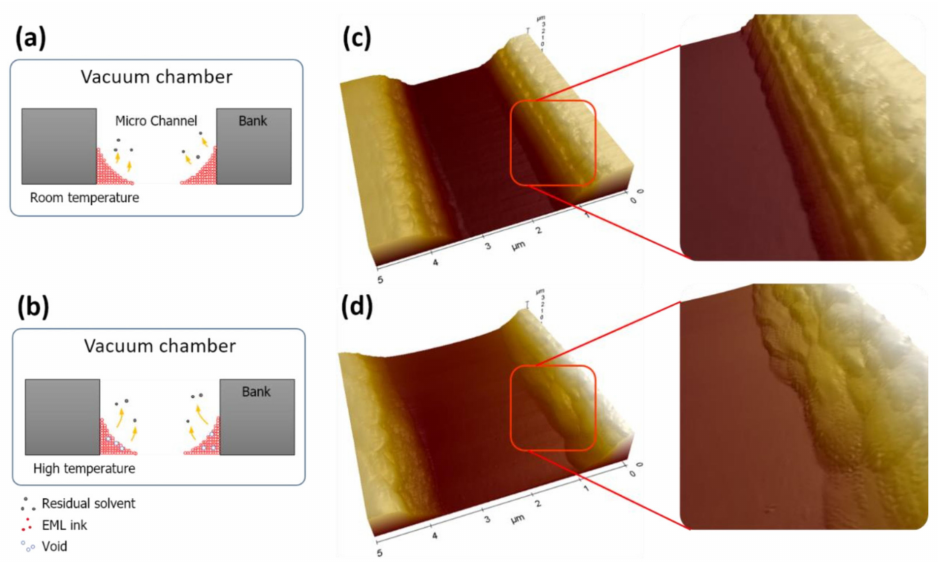
Figure 6. Schematic diagram of the residual solvent behavior and ink solidifying state ( a ) at room temperature and ( b ) at high temperature in the vacuum drying process. The AFM images of the solidified ink in the microchannel at ( c ) room temperature and ( d ) high temperature according to the vacuum drying